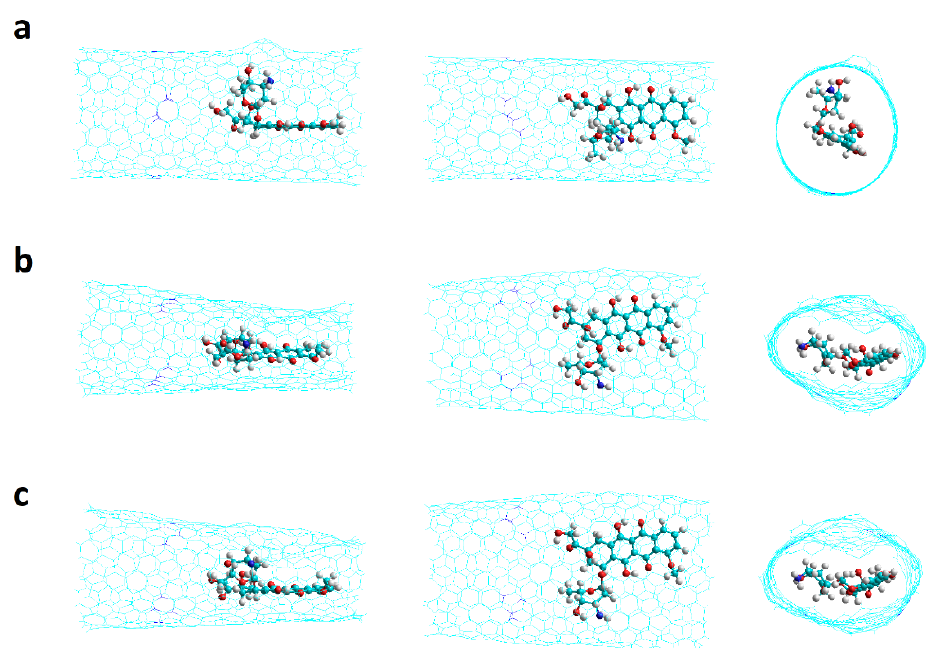
Figure 4. Representation of encapsulated DOX-CNT complex for nitrogen-doped chiral nanotube with one haeckelite defect, Ch(13,08)8N-Hk1-DoxDIn.v1p, at different simulation times. (a) 0 ns; (b) 2 ns; ( c ) 100 ns. Two laterals and one frontal view are shown.